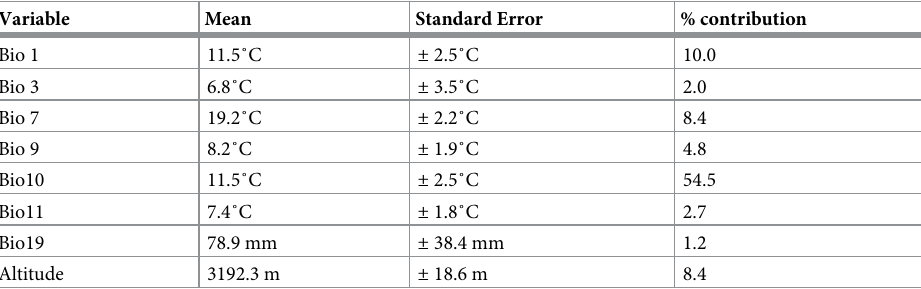
Fig 4. Cumulative frequencies of the bioclimatic variables associated with the niche breadth of P . hartwegii . Records within the intervals of each bioclimatic variables: a) mean annual temperature (Bio1); b) isothermality (Bio3); c) mean annual temperature range (Bio7); d) mean driest quarter temperature (Bio9); e) mean warmest quarter temperature (Bio10); f) mean coldest quarter temperature (Bio11); and g) coldest quarter precipitation (Bio19). https://doi.org/10.1371/journal.pone.0229178.g004 Table 1. Bioclimatic variables and their percent contributions associated with the niche breadth of P . hartwegii according to Jackknife